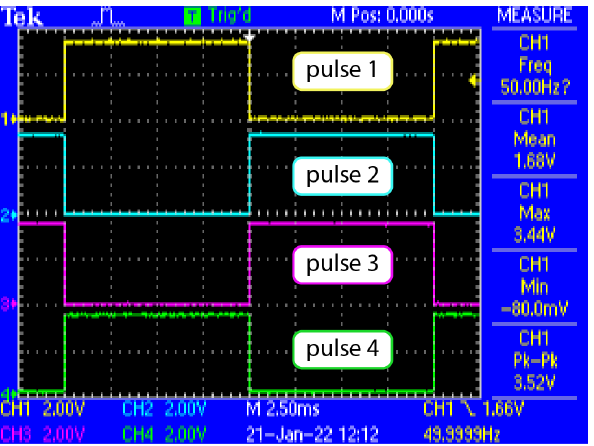
Figure 20. 50Hz square wave generated by the FPGA (measured on Pmod Connector